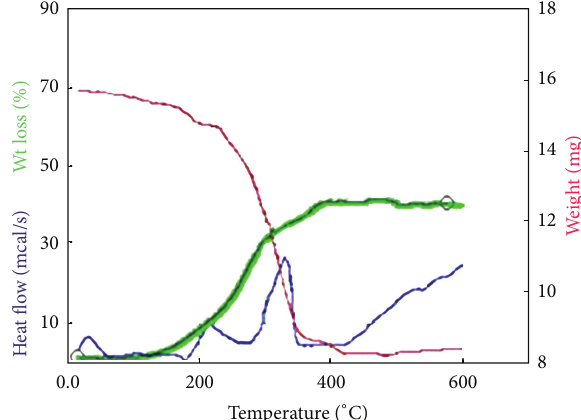
Figure 5: TGA and DSC curves for Fe/SiO 2 precursor.